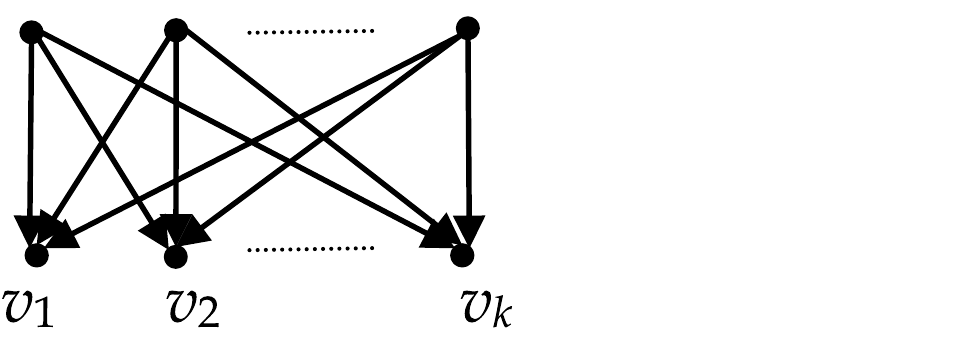
Figure 5. The topology relation of even-order equivalent